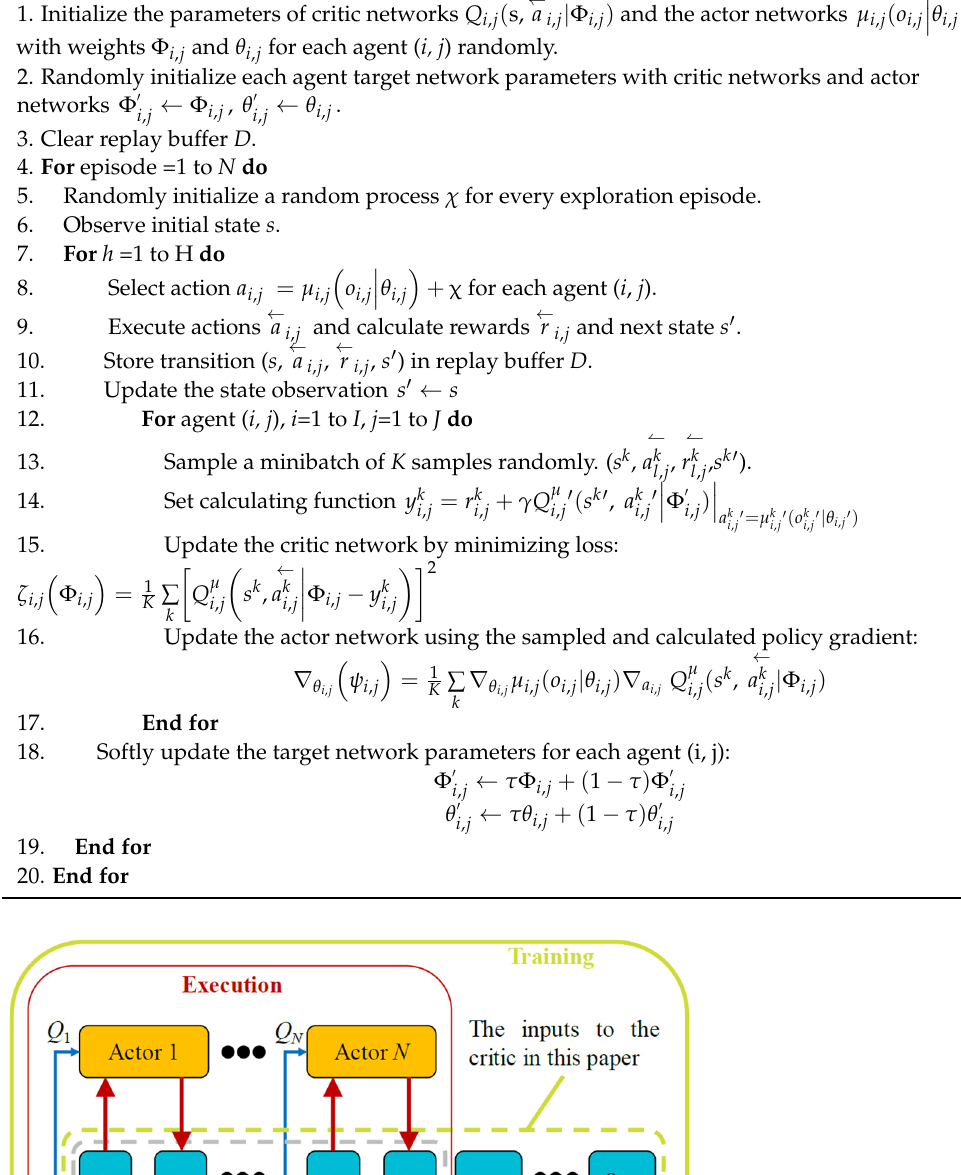
Algorithm 1. MADDPG for grid edge control.